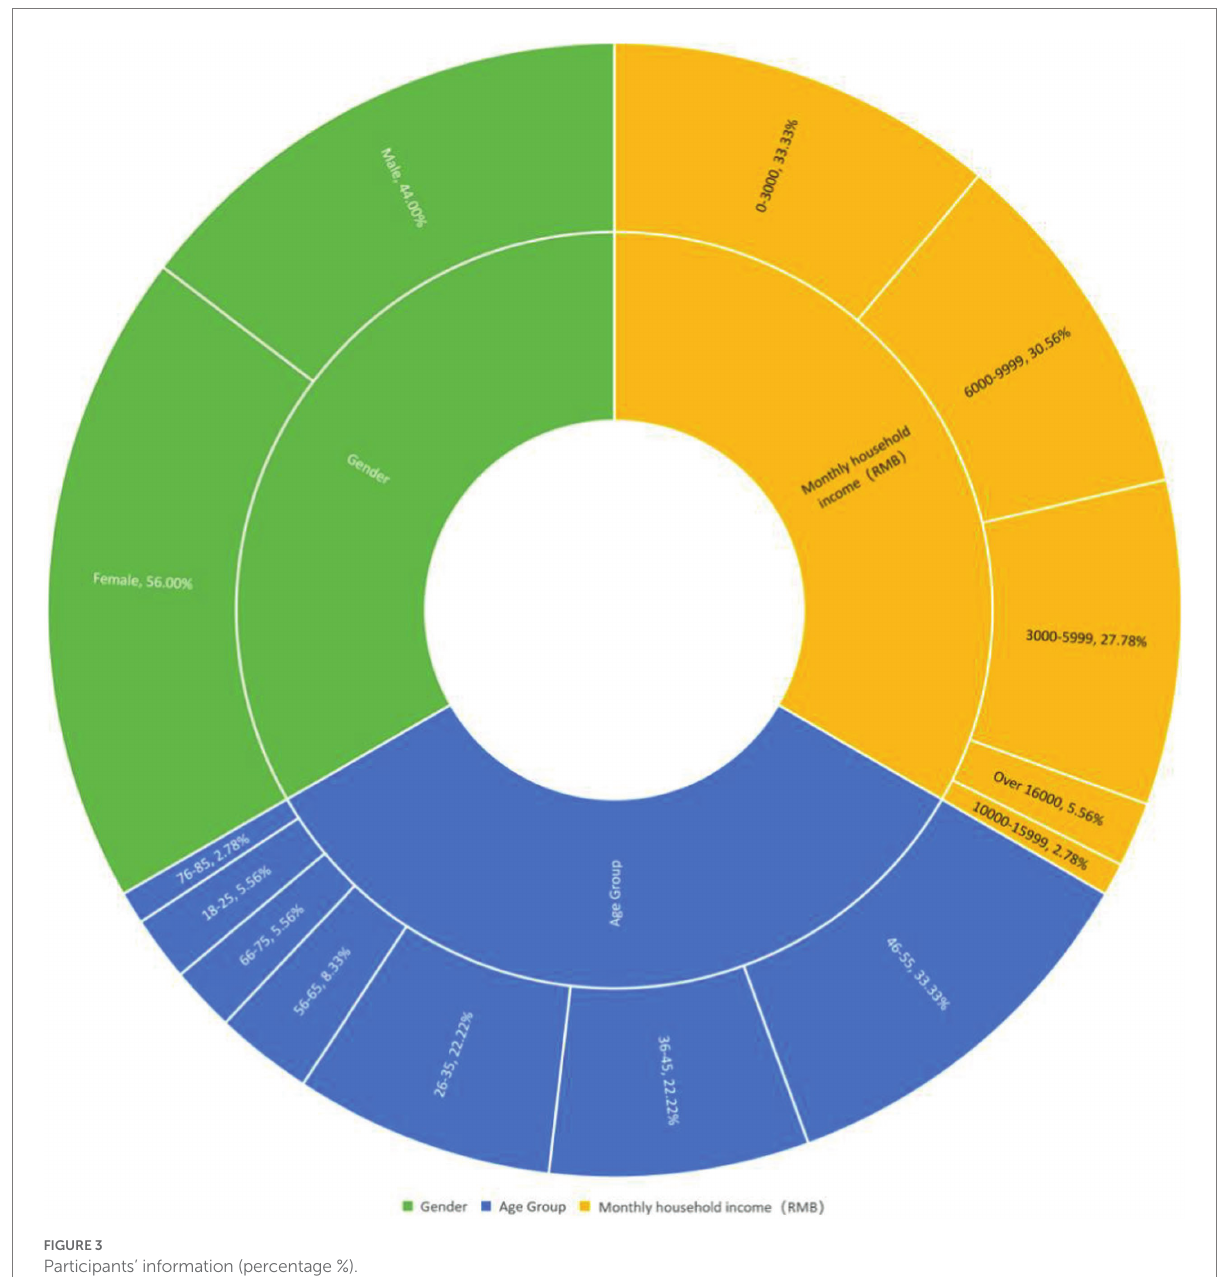
FIGURE 3 Participants’ information (percentage